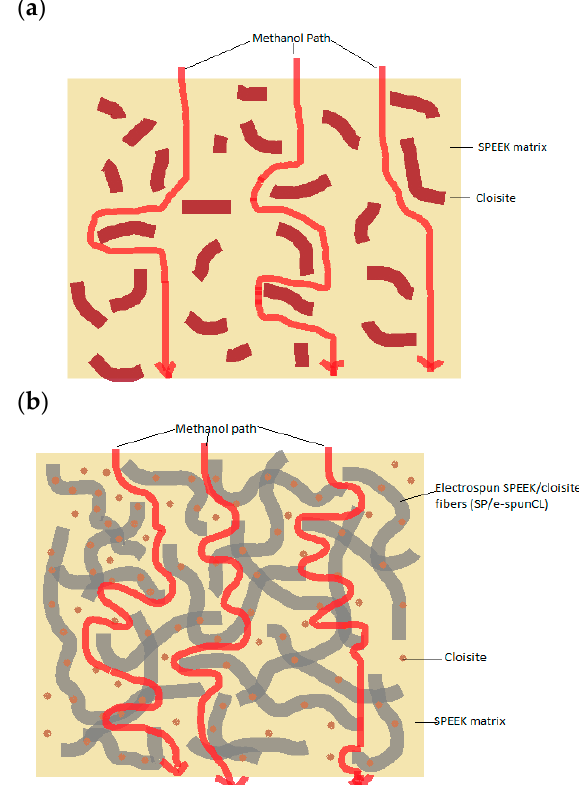
Figure 7. The comparison of methanol path between ( a ) SPEEK/cloisite membranes ( b ) Void-free SP/e-spunCL.